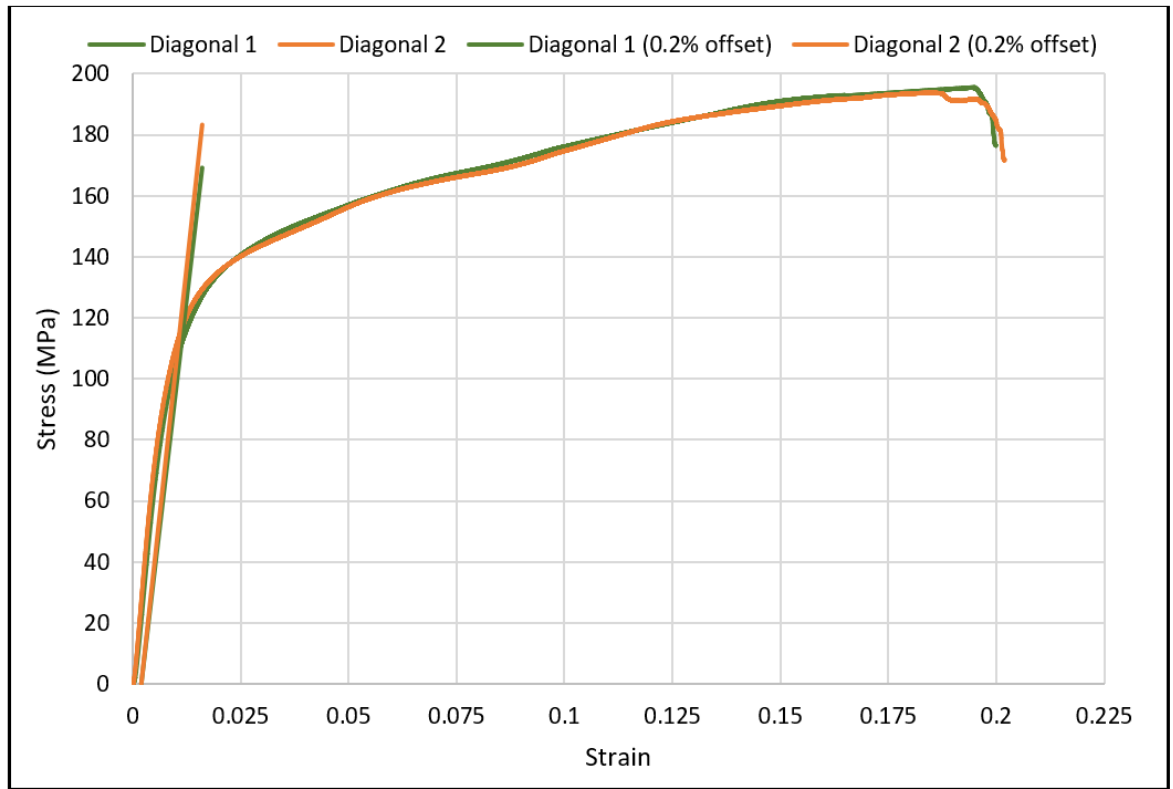
Figure 8. The 0.2% offset yield strength for diagonal scaffolds. Figure 7. The 0.2% offset yield strength for cubic scaffolds. Table 5. Flexural properties of the cubic and diagonal scaffolds.